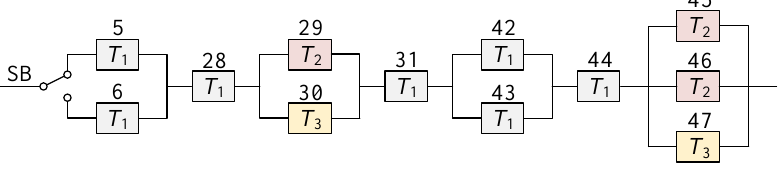
Figure 9. Reliability block diagram of swapping